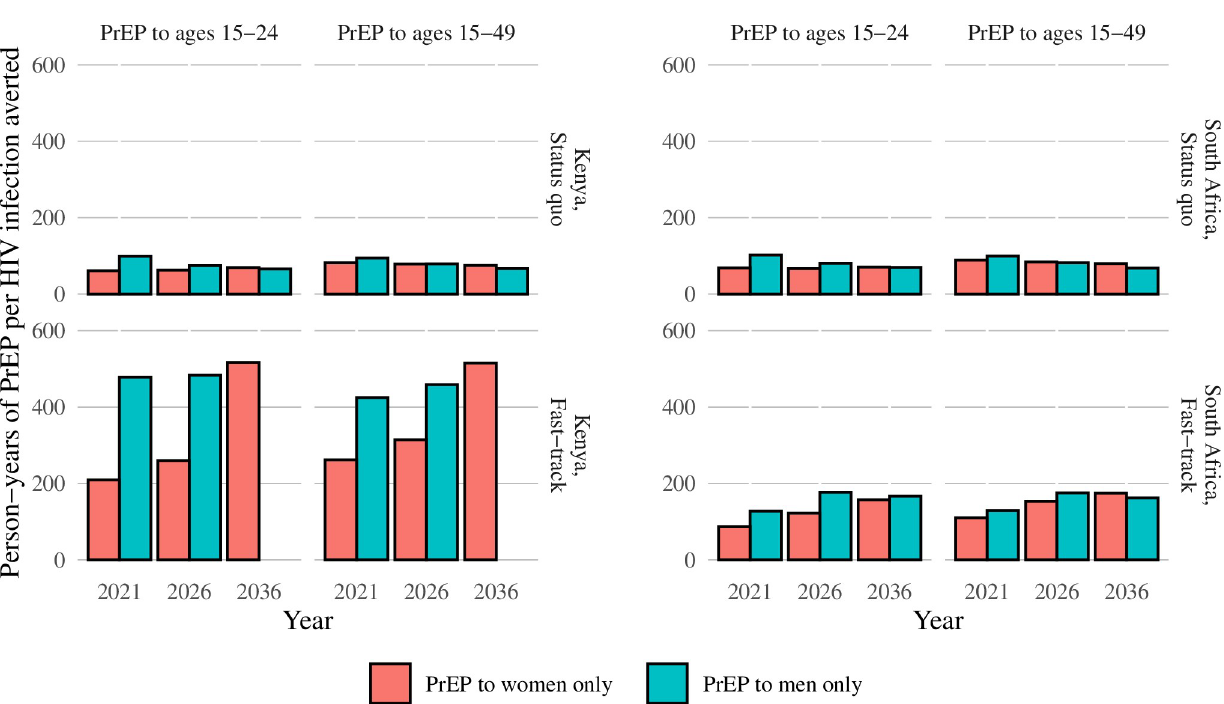
Fig 3. Number of person-years of PrEP needed to prevent one HIV infection by country, baseline scenario, and PrEP provision strategy.